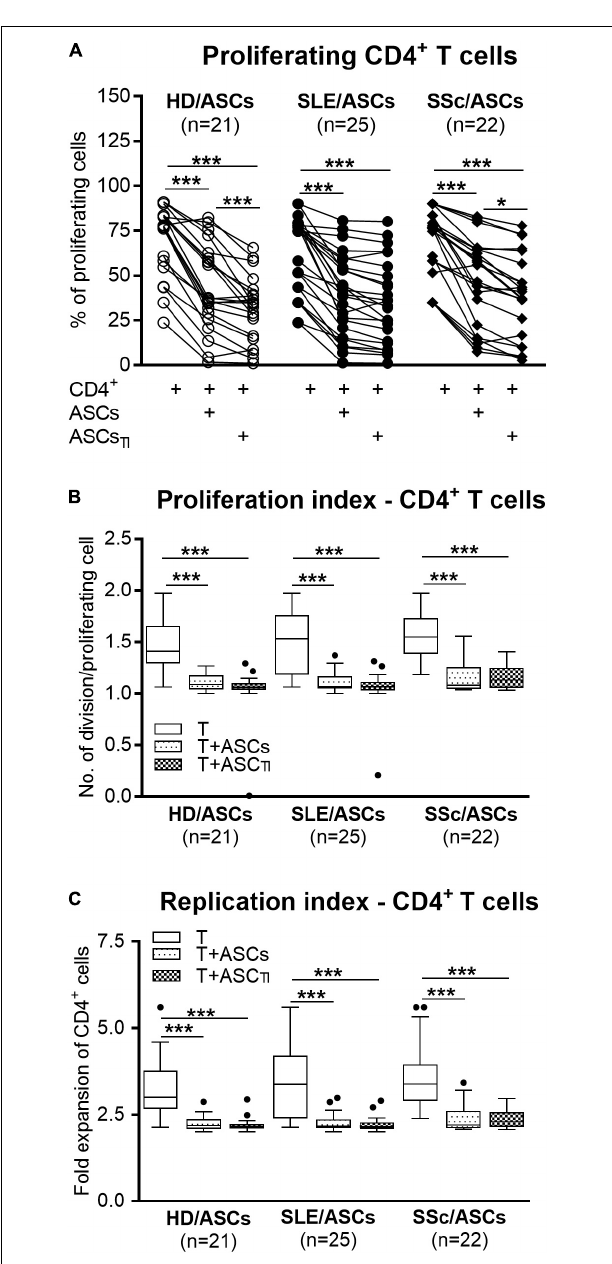
FIGURE 2 | Inhibition of proliferation of purified CD4 + T-cells co-cultured with ASCs. CD4 + T-cells purified from PBMCs of 15 healthy blood volunteers were stimulated with anti-CD3/anti-CD28 antibodies and cultured alone (T) or co-cultured with ASCs or ASCs TI obtained from 5 HD, 14 SLE, and 13 SSc patients. (A) After 5 days culture the proliferation of CD4 + T-cells was analyzed by flow cytometry. (B) Proliferation index and (C) replication index were calculated based on flow cytometry data. Other explanations as in Figure 1 . * P < 0.05, ** P < 0.01, *** P < 0.001 for intra-group comparisons.